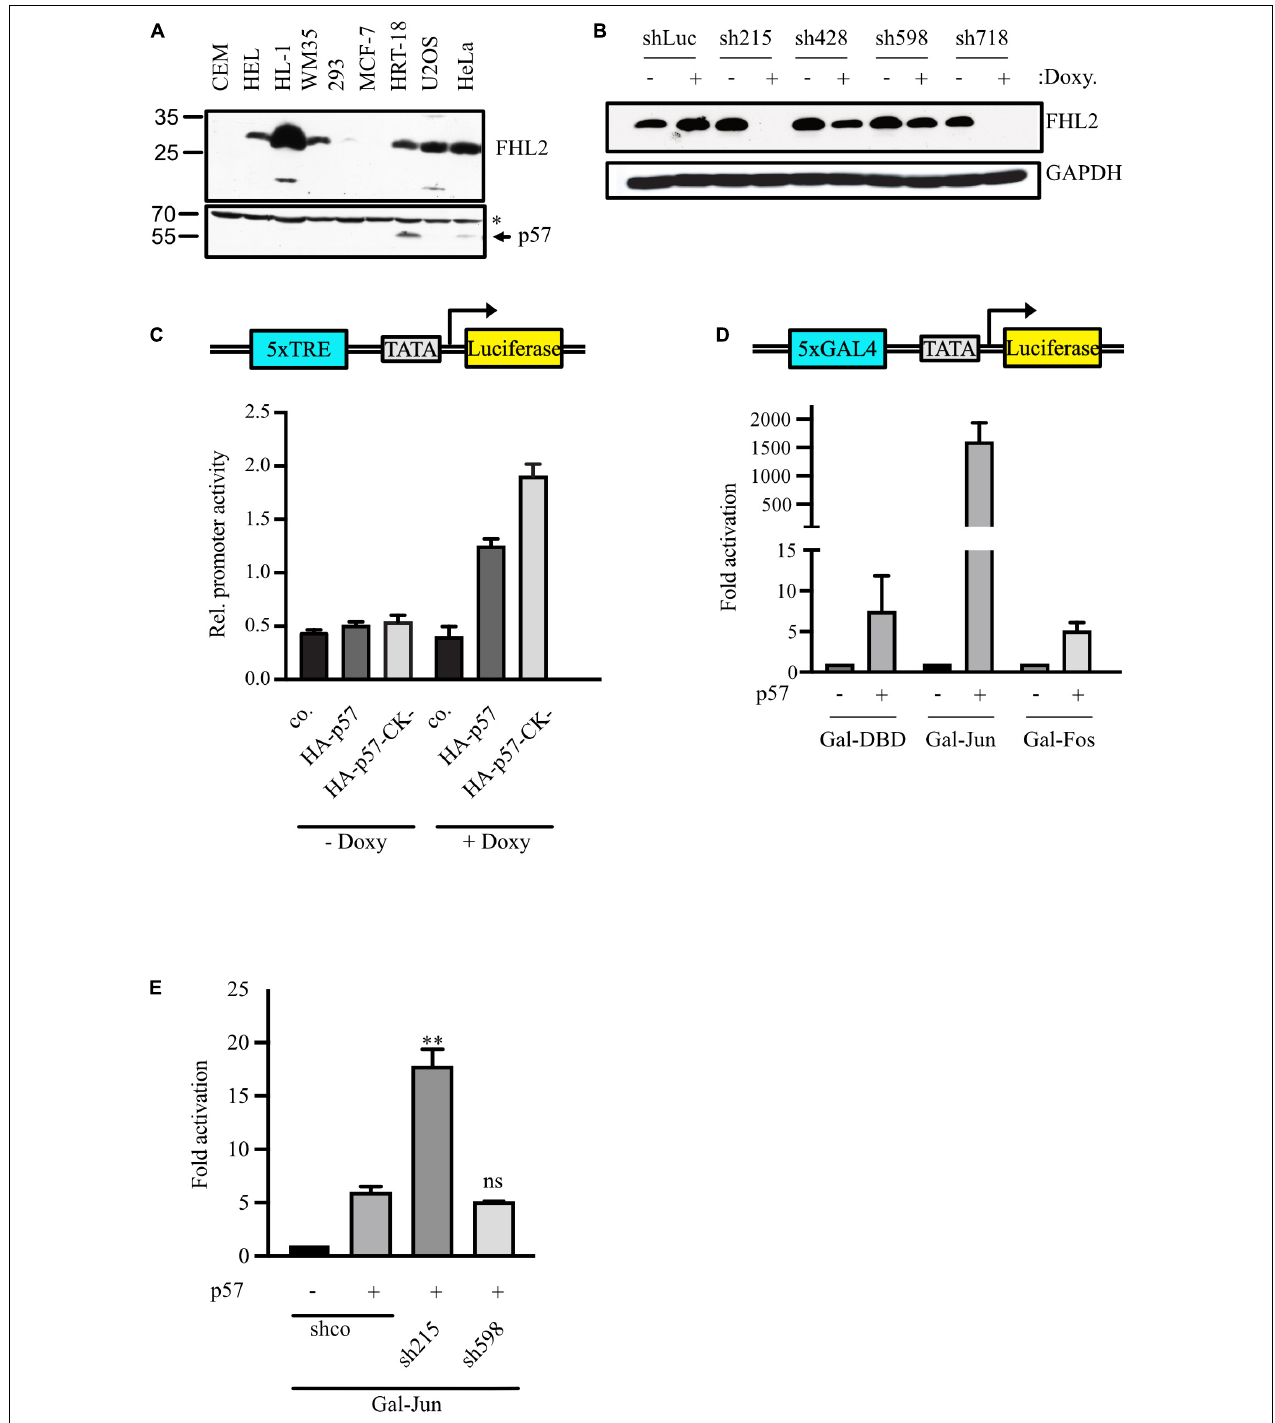
FIGURE 1 | p57 activates AP-1-dependent promoters by inducing c-Jun transactivation independent of FHL2. (A) Protein levels of FHL2 and p57 in different cell lines. 100 µ g of total protein extract were analyzed by immunoblotting for FHL2 and p57 using a mouse monoclonal FHL2- and a rabbit polyclonal p57-specific antibody. CEM, human leukemic; HEL, human erythroleukemic; HL-1, mouse cardiac muscle; WM35, human melanoma; 293, human embryonic kidney; MCF-7, human breast cancer; HRT-18, human colon cancer; U2OS, human osteosarcoma; HeLa, human cervix carcinoma. The unspecific band at 70 kD ( ∗ ) after probing for p57 was used to judge equal loading. (B) Knockdown of FHL2 using four different doxycyclin-inducible shRNAs in stable pools of lentivirally transduced HRT-18 cells. Western blot analysis of extracts obtained from HRT-18 cells. The expression of shRNAs was induced by the addition of doxycycline (1 µ g/mL) for 72 h.